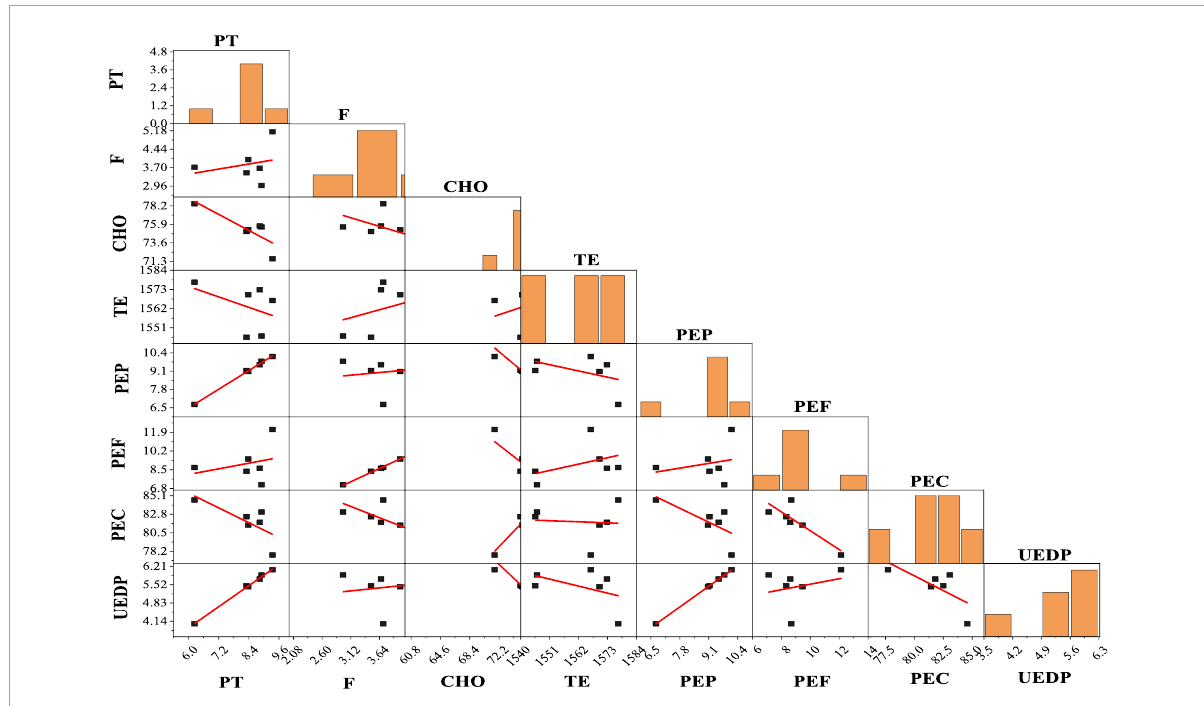
FIGURE2 Scatterplot matrix analysis of protein (PT), fat (F), carbohydrate (CHO), and energy values contributions. TE, total energy; PEP, proportion of total energy due to protein; PEF, proportion of total energy due to fat; PEC, proportion of total energy due to carbohydrate; UEDP, utilizable energy due to protein.